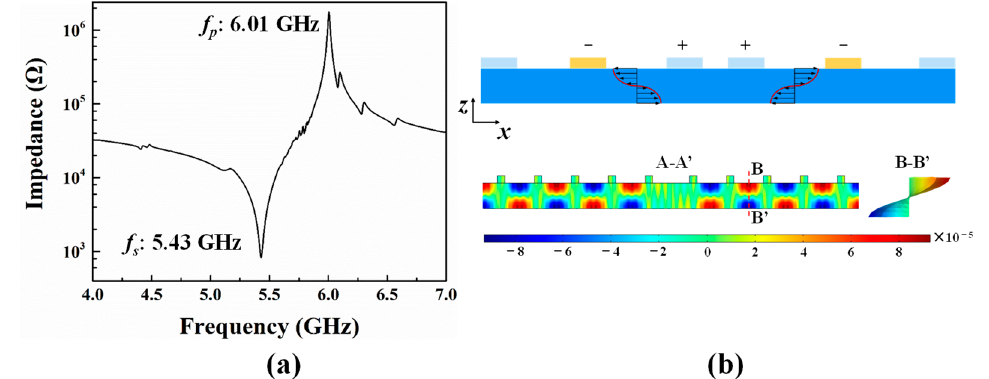
Figure 4. ( a ) The simulated impedance curve of resonator with pentagon spiral electrodes. ( b ) The simulated horizontal displacement mode shape at resonance frequency of A 1 mode along the A-A’ cross section and the horizontal displacement deformation in the B-B’ cross